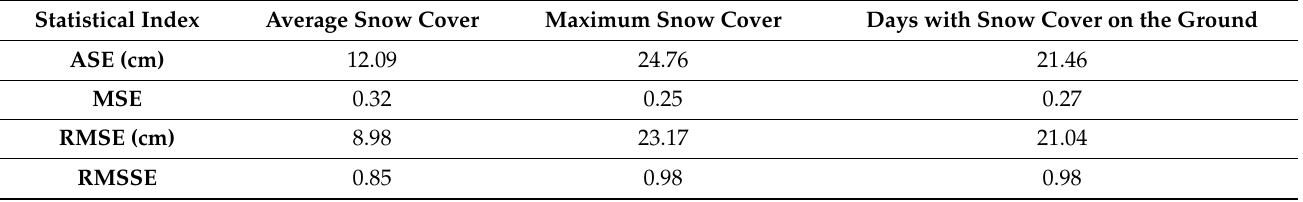
Table 4. Statistical indices to evaluate the performance of interpolations related to the three variables under